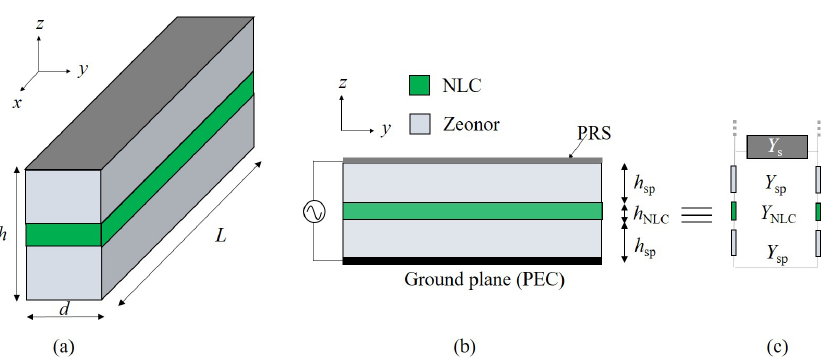
Figure 2. ( a ) A schematic 3-D view of a 1-D unidirectional LWA based on PRS and NLC, ( b ) its cross section along the yz -plane, and ( c ) the related transverse equivalent network. The biasing scheme is shown only in ( b